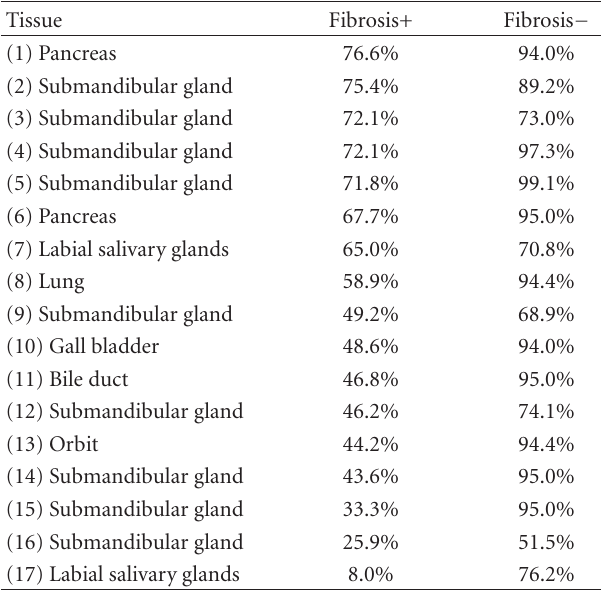
Table 5: Recounting in each areas of 17 samples containing both fibrotic and nonfibrotic parts. All patients were diagnosed with IgG4-RD but had biopsy specimens that were too small (samples 1–14) or with relatively large fibrotic areas inadequate to diagnose IgG4-RD (samples 15–17). All samples had > 10 IgG4+ cells per HPF.